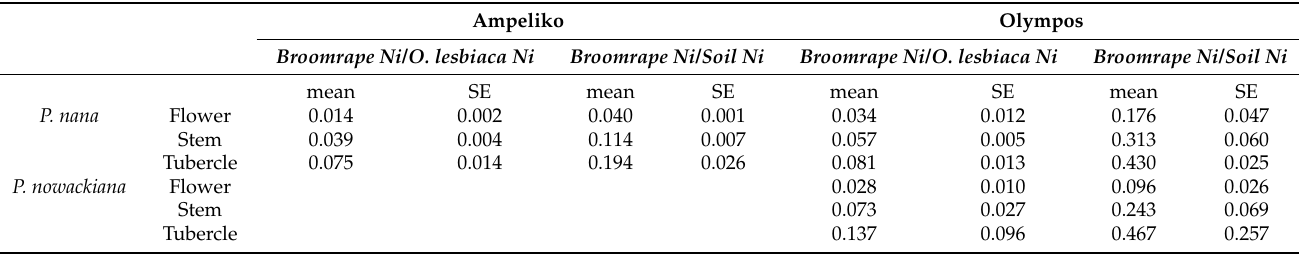
Table 2. Quotient of Ni concentration in broomrape species parts versus Ni concentration in O. lesbiaca leaves and soil sampled from two serpentine sites (Ampeliko, Olympos) of the island of Lesbos, Greece. Mean ( ± 1 Standard Error, SE) values are presented.